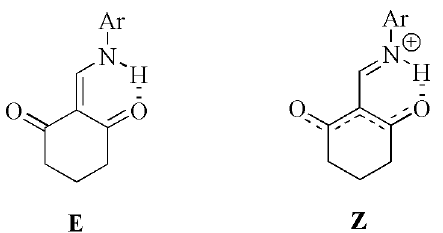
Figure 5. 2-(Arylaminemethylidene)cyclohexane-1,3-dione and its zwitterionic form.